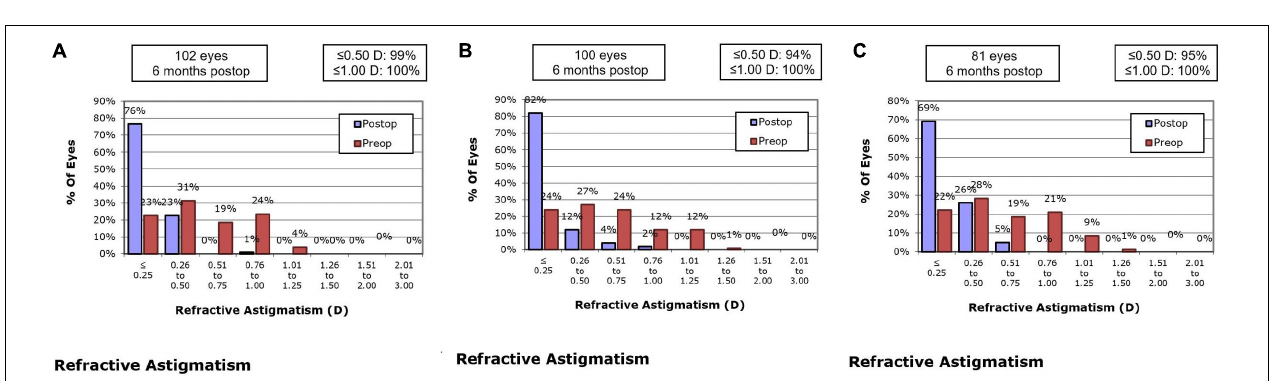
FIGURE 3 | Spherical equivalent refractive accuracy at postoperative 6-month. (A) SMILE group, (B) wavefront optimized group, (C) topography-guided custom ablation treatment group.